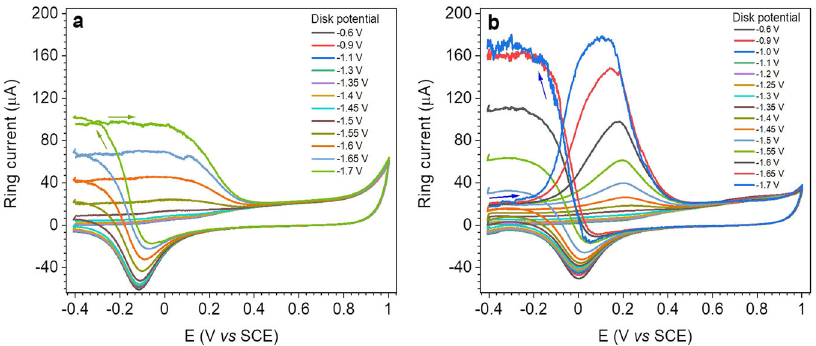
Fig. 5 CO2RR products determination by RRDE in 0.5 M KHCO 3 . a CVs registered in N 2 -saturated electrolyte and b CVs registered in CO 2 - saturated electrolyte at the Pt ring at 0.2 Vs − 1 and 3500 rpm for different potential values applied at the Cu-GCN(20) modi fi ed GC disk. The catalyst loading used for these measurements was 66 µg cm − 2